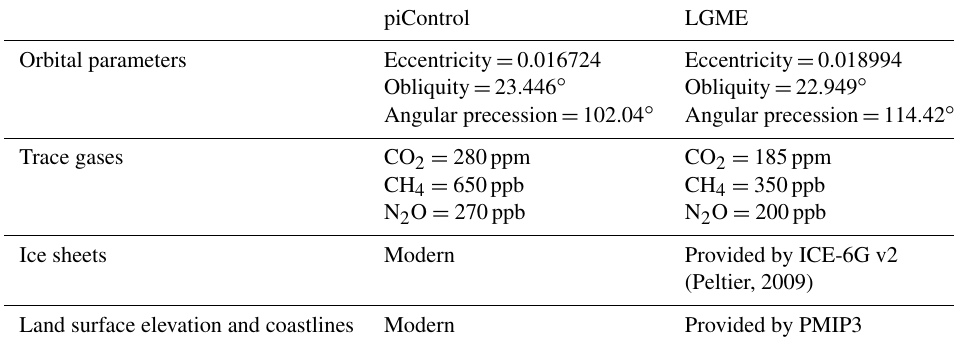
Table 2. Main changed boundary conditions used for the piControl and LGME